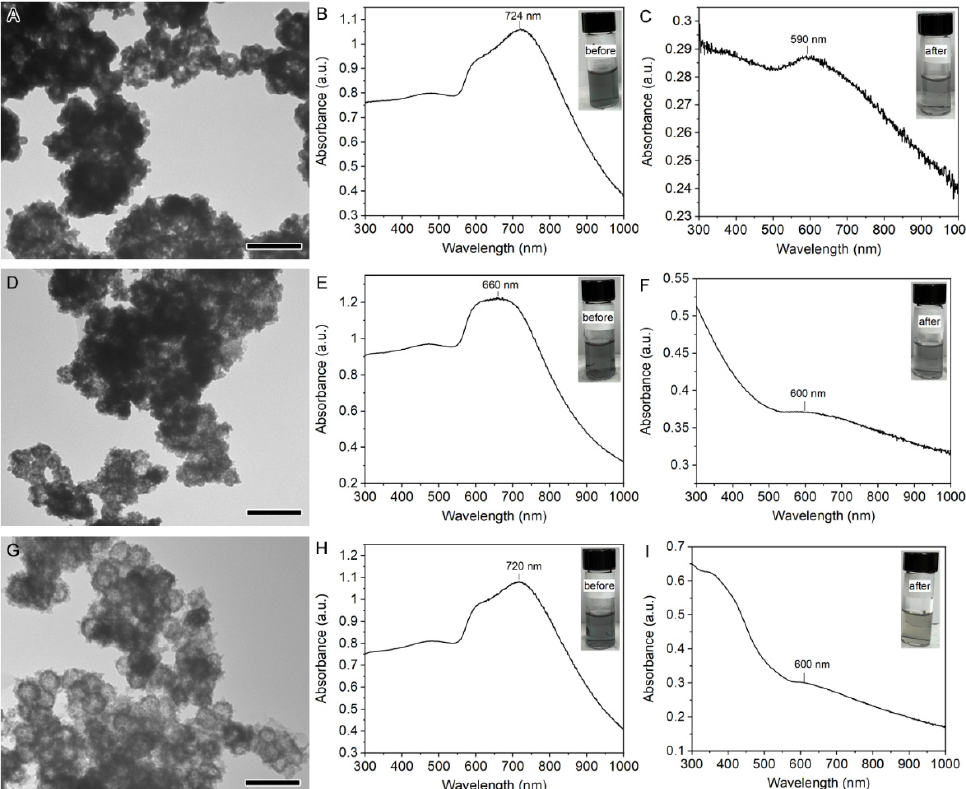
Figure 6. TEM images of products and UV-vis spectra before and after the galvanic replacement reaction between PEG-SH coated CuNPs and HAuCl 4 in different solvents: ( A – C ) water; ( D – F ) ethanol; and ( G – I ) isopropanol. The scale bar is 100 nm.